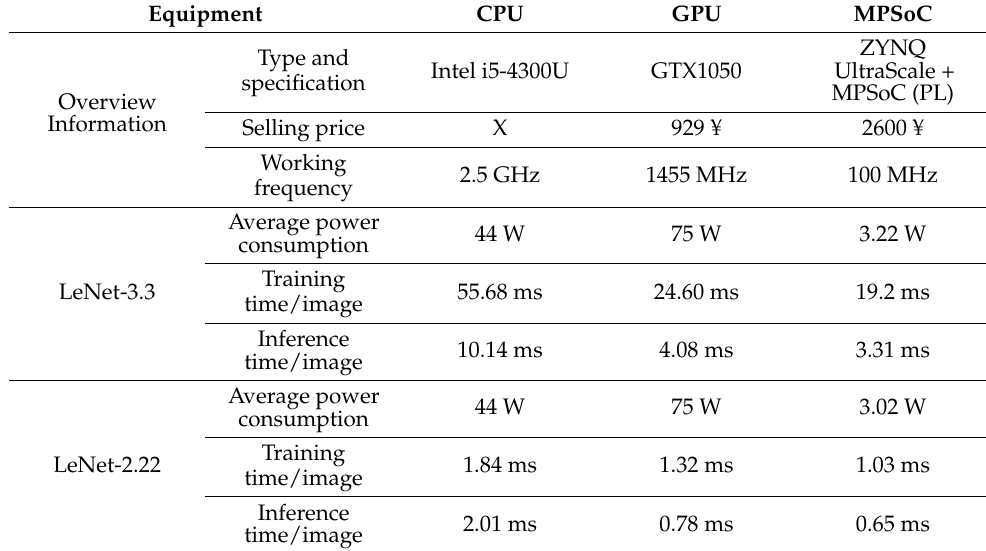
Table 4. Overall performance